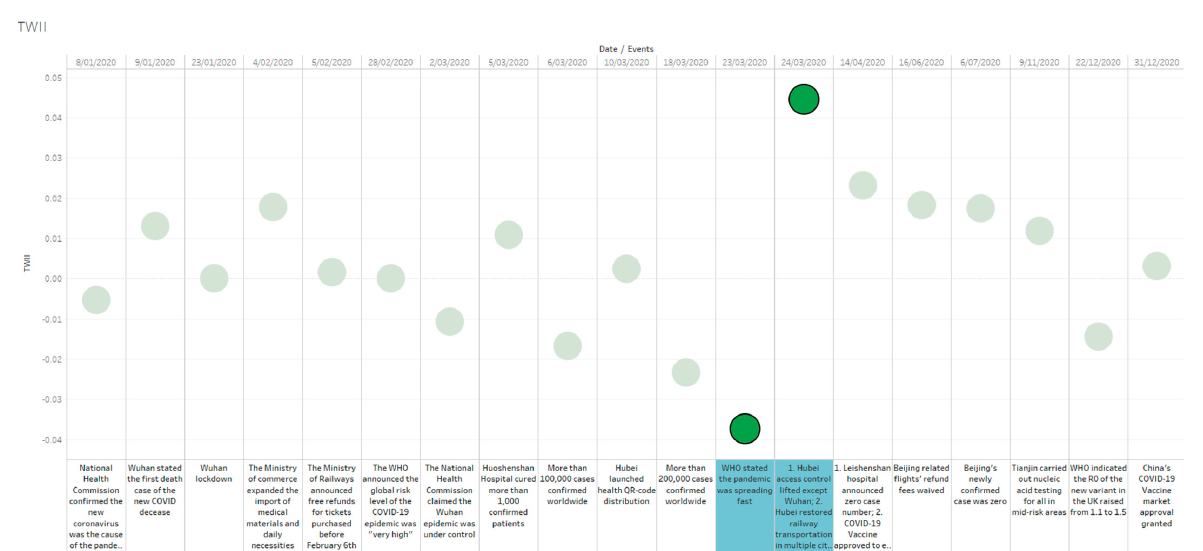
Figure 6. TWII’s trends on relevant social events.